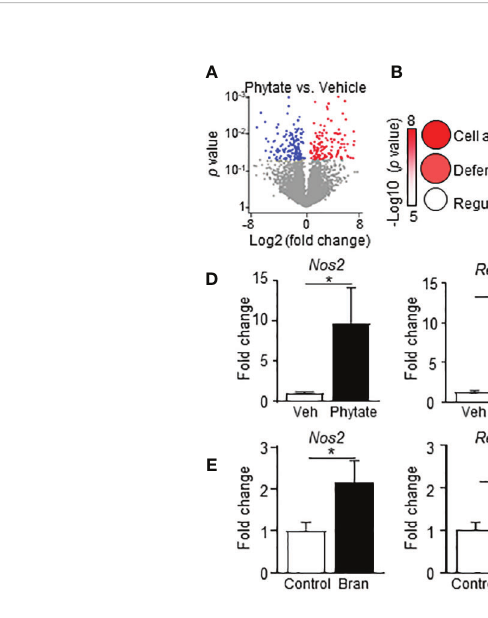
FIGURE 4 Phytate consumption primes elevated epithelial antimicrobial defense. (A) Volcano plot showing differentially expressed LI IEC genes between Vehicle- and 2% phytate-treated naïve mice identi fi ed by RNA-seq. Red: upregulated, blue: downregulated with phytate, p < 0.05. (B) Ontology of the genes upregulated with phytate in (A) . Circle sizes correspond to gene numbers in pathways. (C) Heatmap of relative mRNA expression of IEC